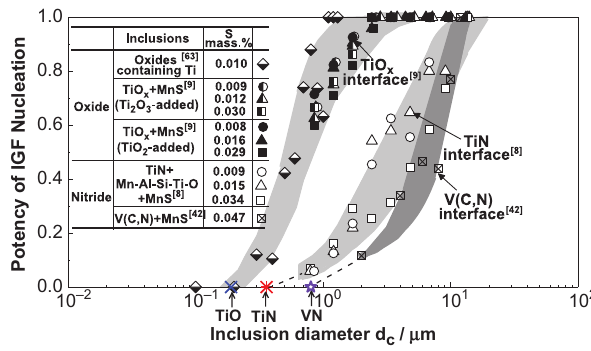
Figure 9: Summary of effect of nuclei inclusion size on IGF nuclea- tion potency from Refs [8, 9, 42, 63].